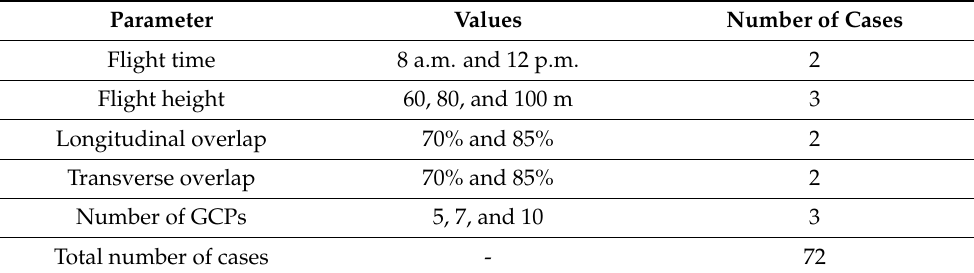
Table 1. Values of the different flight parameters and number of studied cases.